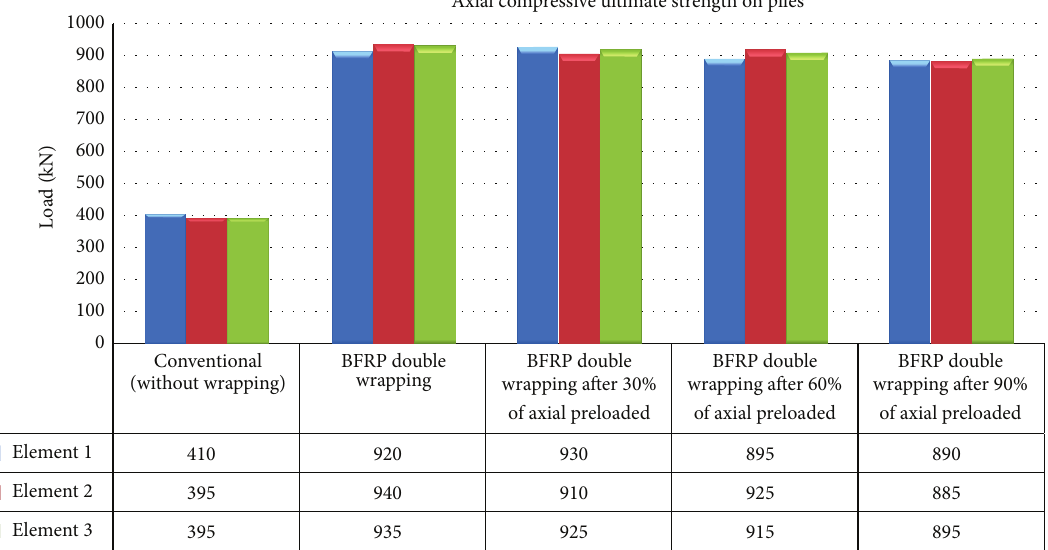
Figure 8: Experimental results of RCC pile elements under the compression.